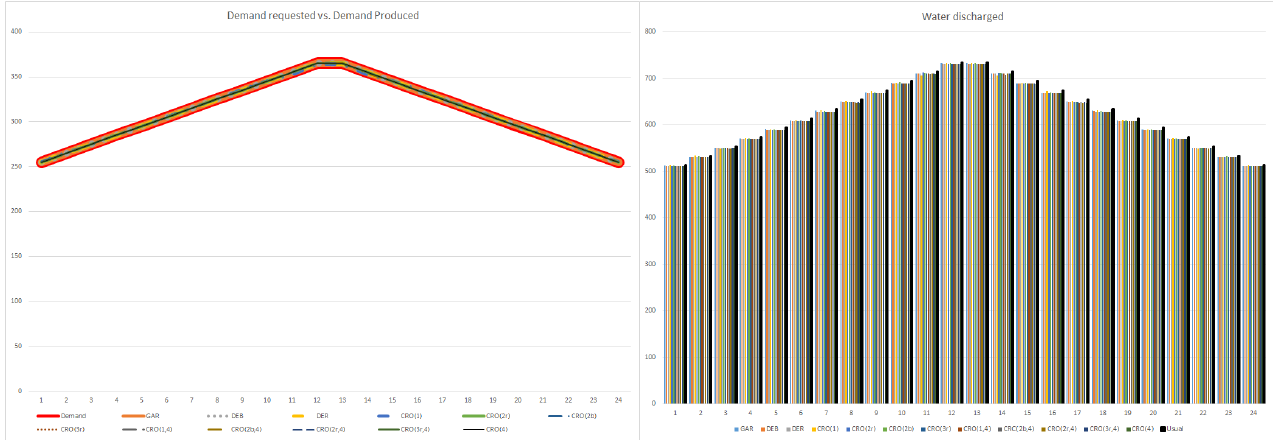
Figure 18. Typical plot of power generated (MW/h)/water discharged (m 3 /s) through time in the Daily dispatch (24